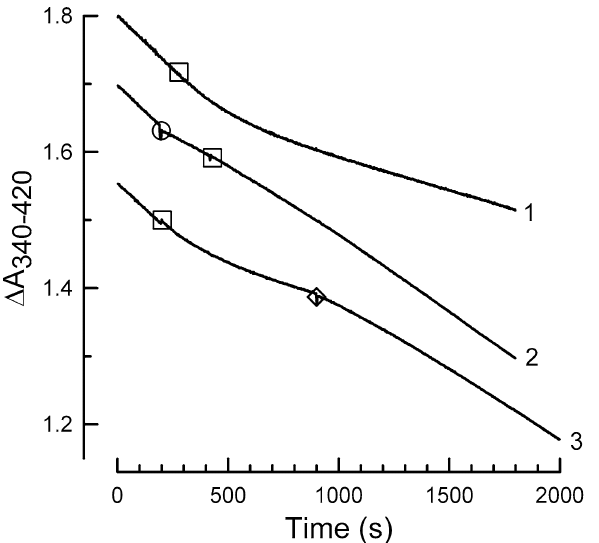
Figure 4. VentA-induced increase in ATPase activity is not blocked by DCCD modification of F O . ATP hydrolysis was assayed as in “Methods”, using 3.36 µg of WT E. coli membrane protein. The mean of ATPase activity during the first 3 min of all assays is 0.83 (± 0.02) U/mg. DCCD was added to each assay at 0.1 mM ( □ ) and ventA was added either before DCCD ( ○ , trace 2 , 10 μM ventA) or after DCCD (◊, trace 3 , 15 μM ventA). During the last 3 min of assays, ATPase activity (± SD, n = 3) is 0.20 (± 0.02), 0.53 (± 0.05), or 0.49 (± 0.06) U/mg for conditions of representative traces 1–3 , respectively.